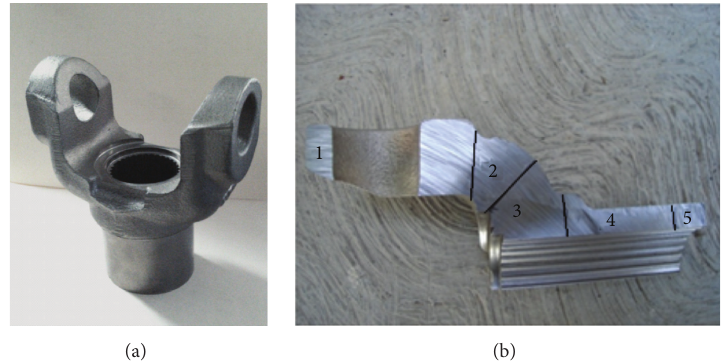
Figure 2: (a) Automotive piece to be analyzed; (b) sections of automotive piece.